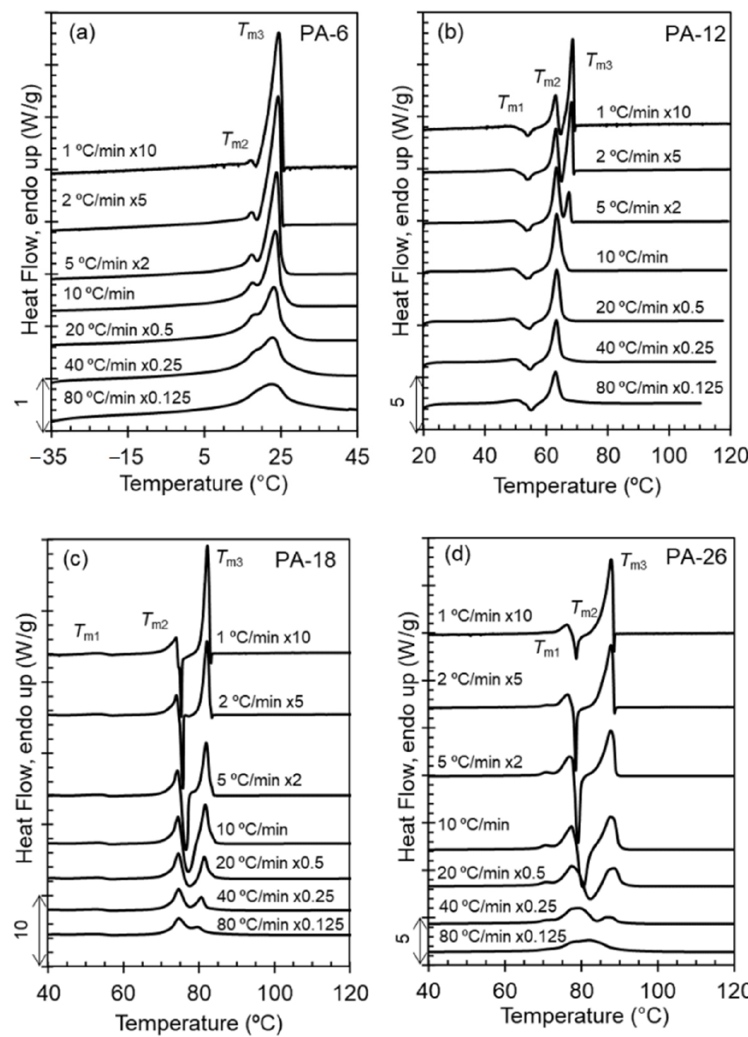
Figure 2. Melting endotherms collected on heating at the indicated rates for ( a ) PA-6, ( b ) PA-12, ( c ) PA-18, and ( d ) PA-26. Prior to melting, samples were cooled from the melt at 40 ◦ C/min. Data have been normalized by heating rate and vertically shifted for clarity.